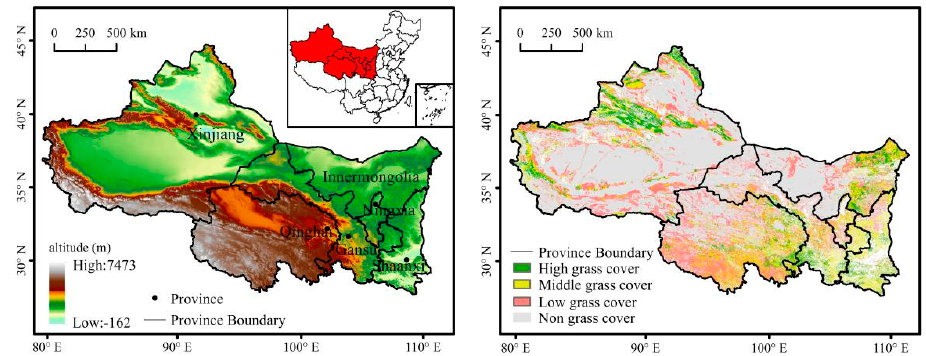
Figure 1. Study area and grassland spatial distribution in Northwest China.